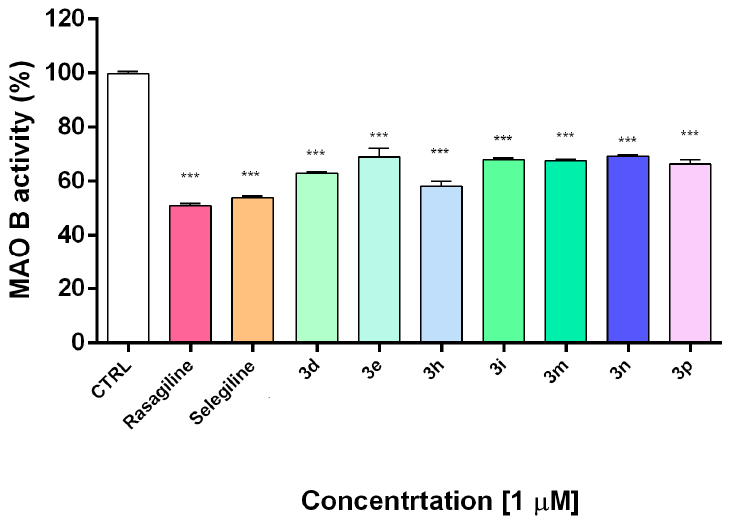
Figure 4. In vitro inhibiting activity of compounds 3d , 3e , 3h , 3i , 3m , 3n , 3p on human recombinant MAO-B enzyme. Data are presented as means from three independent experiments ± SD. Sample series were compared by one-way analysis of variance with Dunnet’s post hoc test. *** p < 0.001, vs. control.